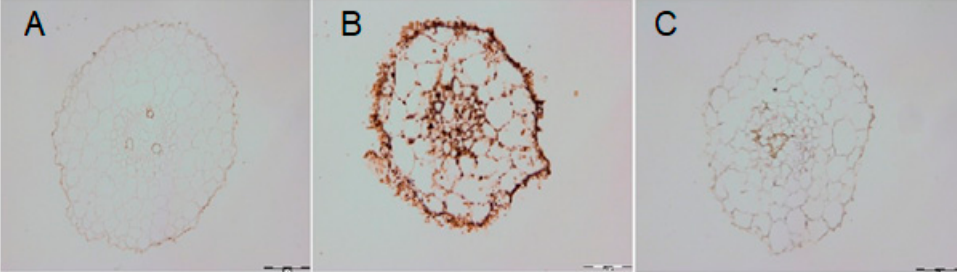
Figure 6. DAB staining and visualization of hydrogen peroxide in the roots of cucumber seedlings: control plants ( A ), plants treated with Cd (the plants after 3 days of treatment with Cd were transferred to the control conditions for another 3 days) ( B ) and plants, in which the heavy metal was withdrawn after 3 days, and then aminoguanidyne was added for the next 3 days ( C ).